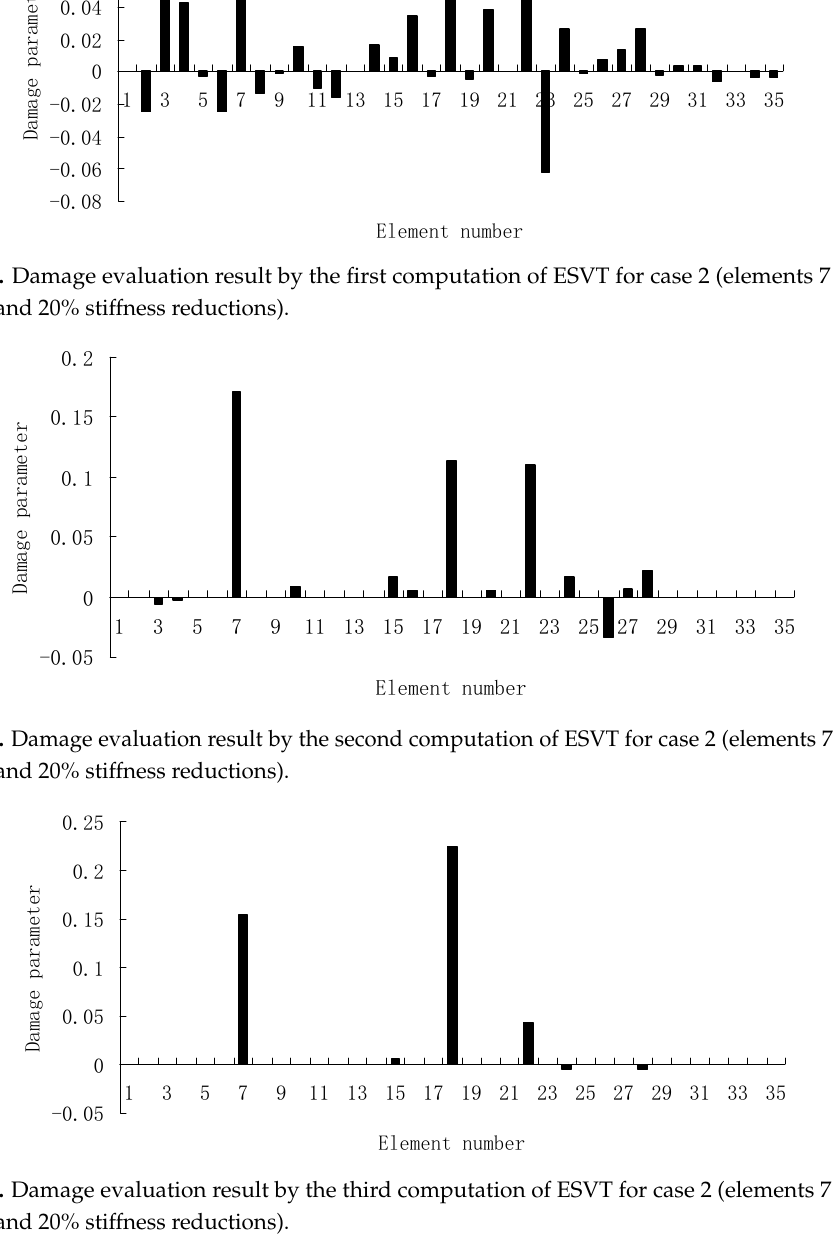
Figure 12. Damage evaluation result by the third computation of ESVT for case 2 (elements 7 and 18 had 15% and 20% stiffness reductions).